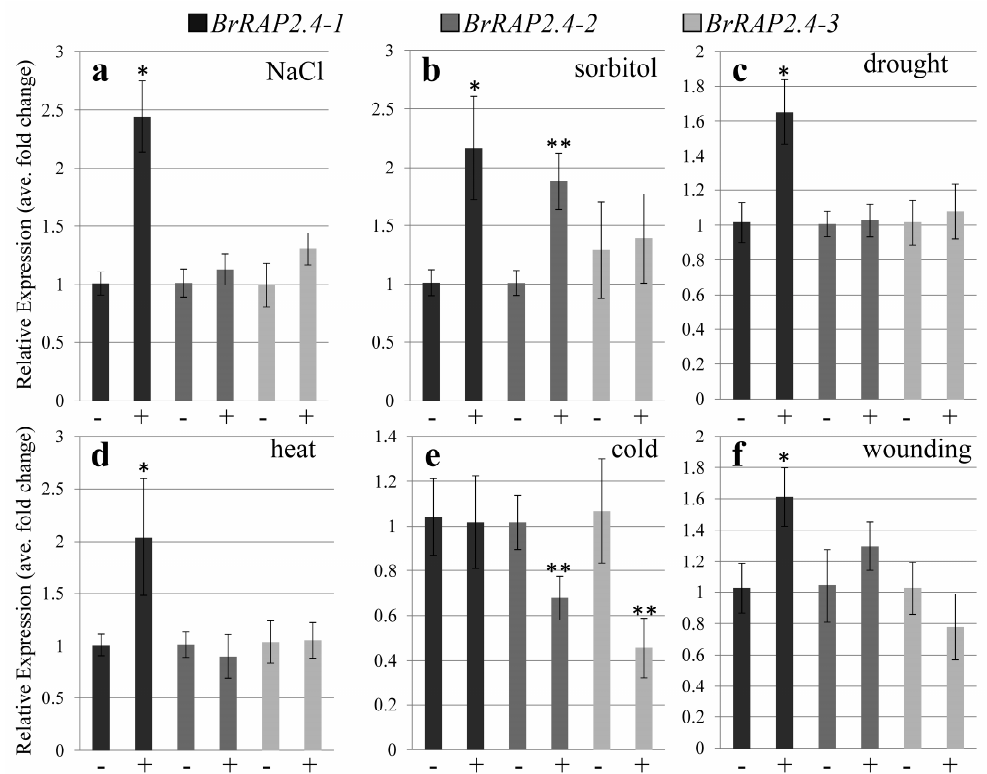
Figure 3. Abiotic stress-dependent expression of BrRAP2.4-1 to -3 . ( a ) Salt stress (NaCl), ( b ) Osmotic stress (sorbitol). ( c ) Drought stress. ( d ) Heat stress. ( e ) Cold stress. ( f ) Wound response. For each sample, 90 ng of total RNA was used. Calculations were normalized against ACTIN2 as an internal control and compared to the BrRAP2.4 untreated samples. Graphs represent averages of at least n = 3 biological replicates. Error bars represent standard deviation. Significant changes (student’s t -test) are indicated by asterisks (* p < 0.05; ** p < 0.01). − , no stress treatment; +, stress treatment